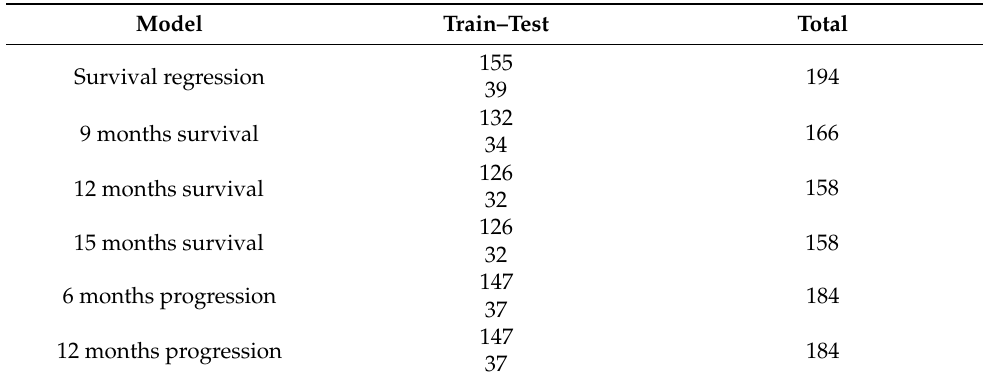
Figure 2. Model building using ML. Table 3. Training and test set patient